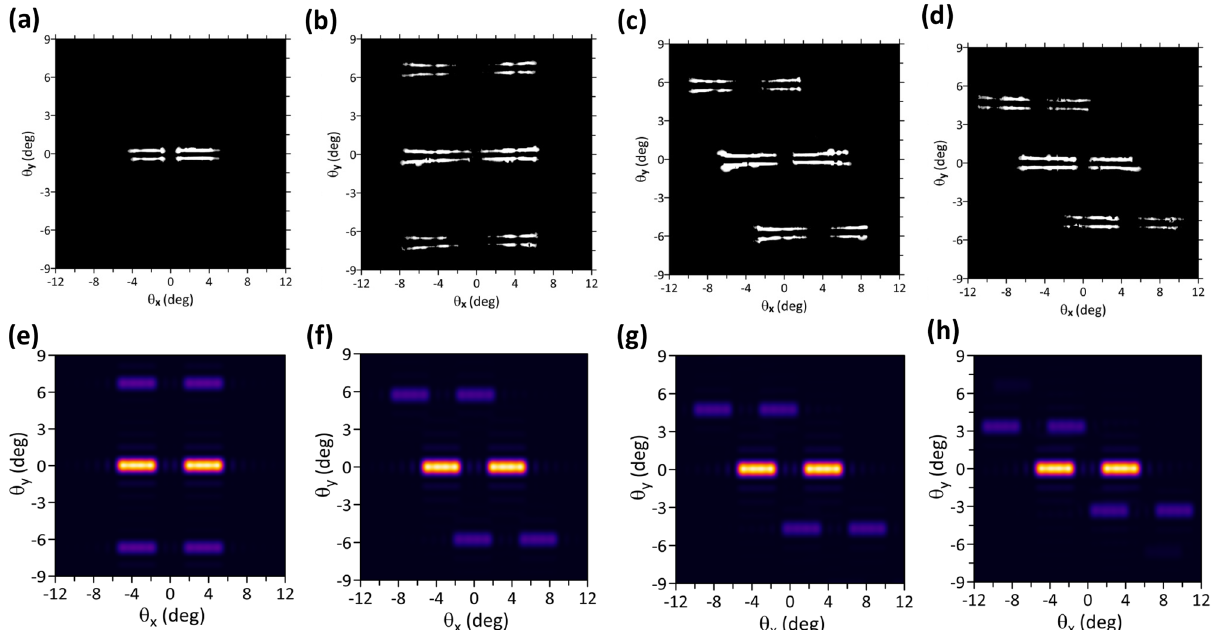
Figure 4. Far-field emission pattern of PCSELs operating above threshold (1.2 × I th ). ( a ), ( b ), ( c ), and ( d ) display the measured far-field patterns of the VIDG-PCSELs of no grating, 0° grating, 30° grating, and 45° grating, respectively. ( e ), ( f ), ( g ), and ( h ) displays the simulated far-field patterns of 0° grating, 30° grating, 45° grating, and 60° grating,